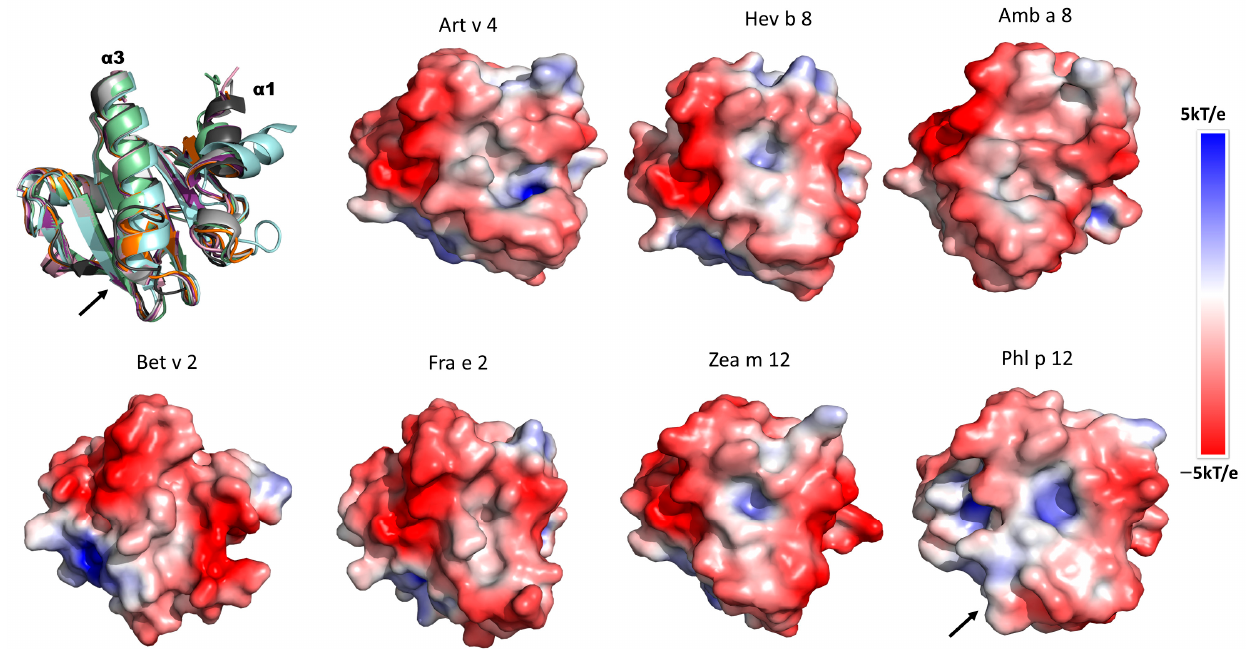
Figure 6. Comparison of the electrostatic potential surfaces in plant profilins’ allergens. Three-dimensional alignment shows the orientation of electrostatic potential charge in profilins’ surfaces on α -helices 1 and 3. The profilins are ordered from the highest to the lowest recognition by 2D10. The positive charge patches are in blue, and the negative in red. The black arrows highlight structural differences in Phl p 12 from α -helix 3 to the loop that connects β -strand 7.